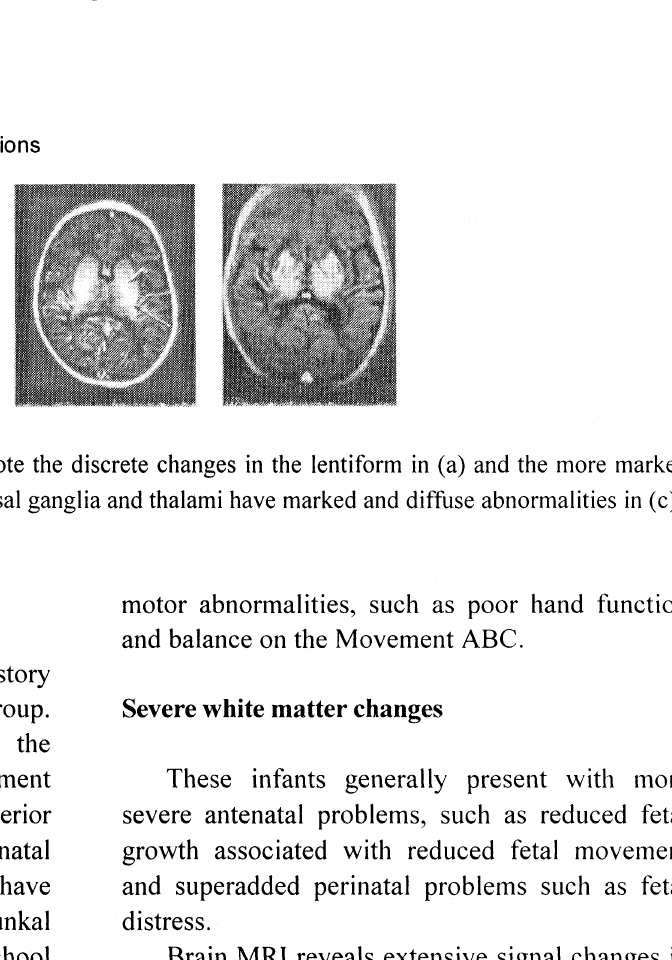
Fig. 1" Axial IR image. Note the discrete changes in the periventricular white matter in children with mild white matter changes (a) and the more marked focal changes (moderate white matter changes) in (b). The child with severe white matter changes had diffuse abnormalities throughout the white matter (c).